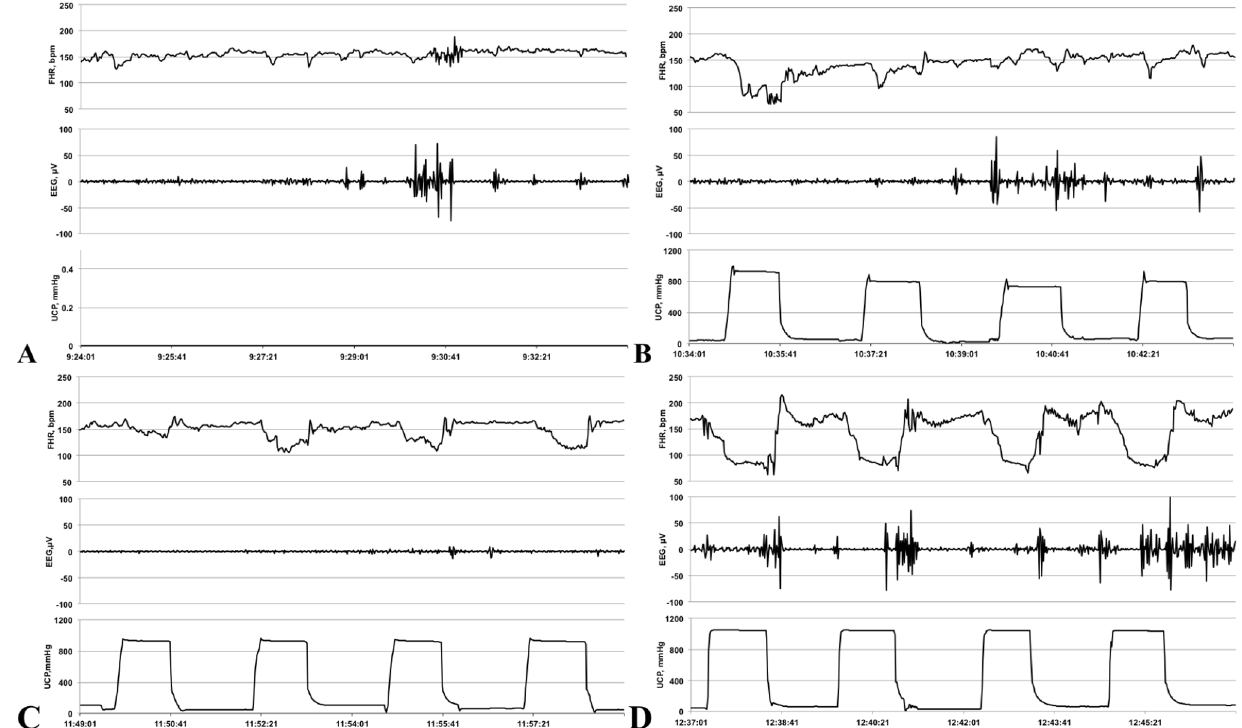
Figure 3. Representative behaviour of the electroencephalogram (EEG) and fetal heart rate (FHR) at baseline and during repetitive umbilical cord occlusions (UCO). 10 minutes of baseline (A), mild (B), moderate (C) and severe (D) UCO series are shown. X axis shows time of the day. The segment during the severe UCO series represents the stage when the adaptive brain shut-down pattern is visible in EEG in phase with FHR decelerations triggered by changes in the umbilical cord occluder pressure (UCP). Note the brief, , 60 seconds lasting, episodes of EEG suppression during each UCO-induced FHR decelerations and EEG amplitude recovery between the UCOs. doi:10.1371/journal.pone.0108119.g003 PLOS ONE |